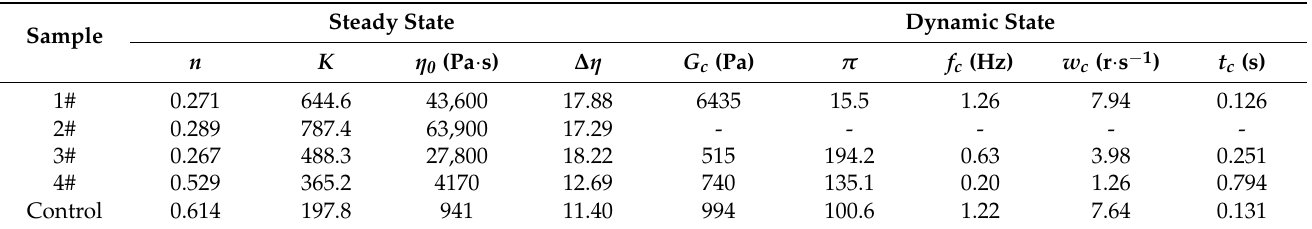
Table 6. Rheological